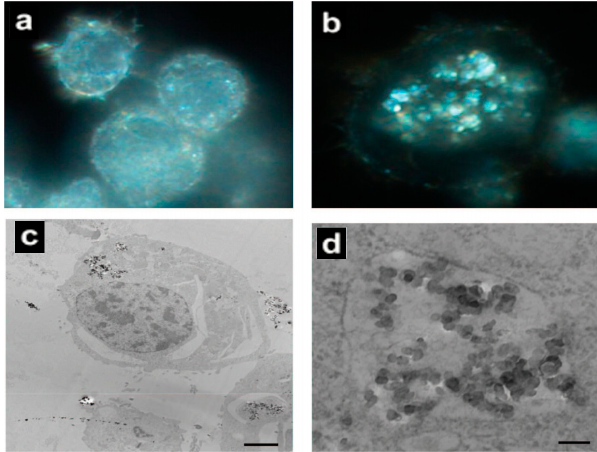
Figure 5. Comparative study on the uptake of Ag nanoparticles by alveolar macrophages. ( a , b ) Light microscope images illustrating uptake of nanoparticles in alveolar macrophages at 100× oil magnification after 6 h. ( a ) Control; ( b ) Cells treated with 30 nm Ag nanoparticles (25 µg/mL) for 6 h; ( c , d ) Low-magnification and high-magnification TEM images of cells that internalized 55 nm Ag nanoparticles (25 µg/mL) into vacuoles after 24 h incubation. The scale bars are 2 µm and 500 nm, respectively. (Reproduced with permission [149]).